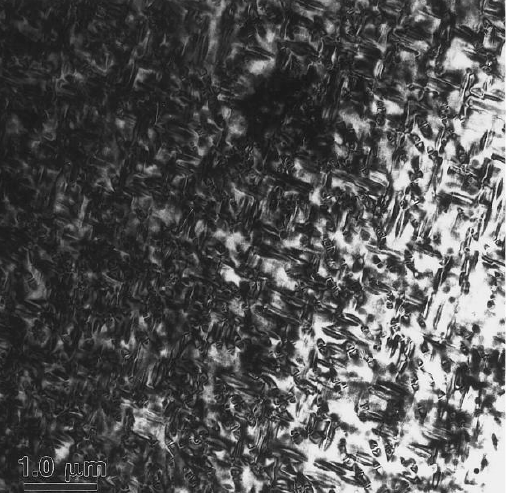
Figure 4. Bright-field (BF) TEM image of a quenched Cu–15Ni–8Sn sample [12] .